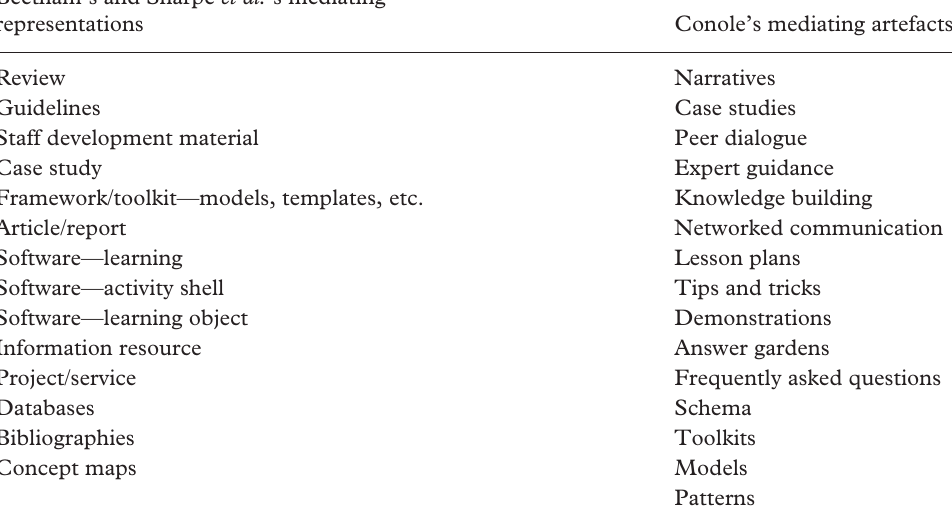
Table 1. Lists of Beetham’s and Sharpe et al. ’s mediating representations (based on Beetham, 2001; Sharpe et al ., 2004) and Conole’s mediating artefacts (from Jones & Conole, 2006) Beetham’s and Sharpe et al. ’s mediating